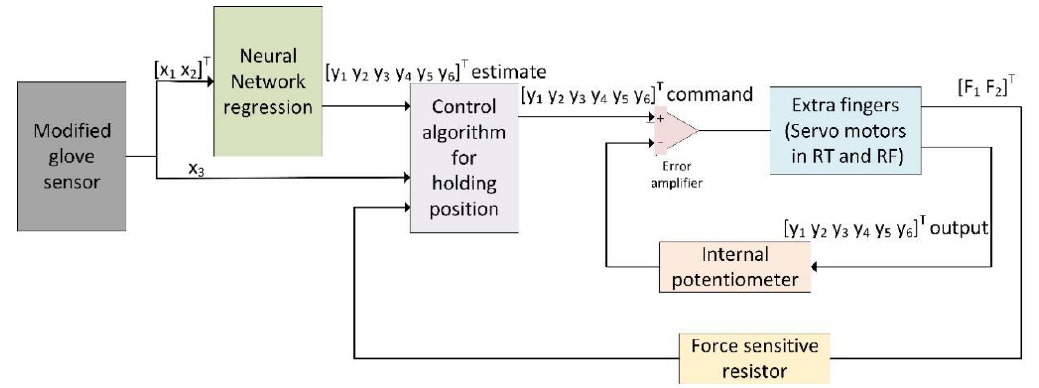
Figure 7. Implemented control algorithm block diagram for posture control coordination.